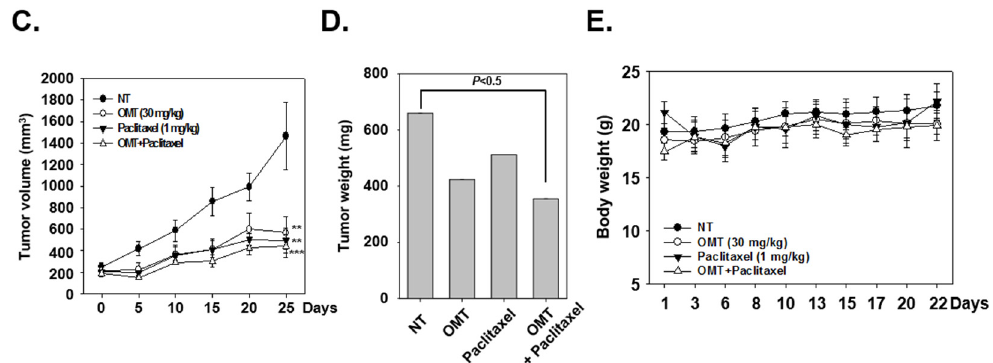
Figure 6. Anti-tumor effects of OMT and paclitaxel in a human lung cancer xenograft mouse model.